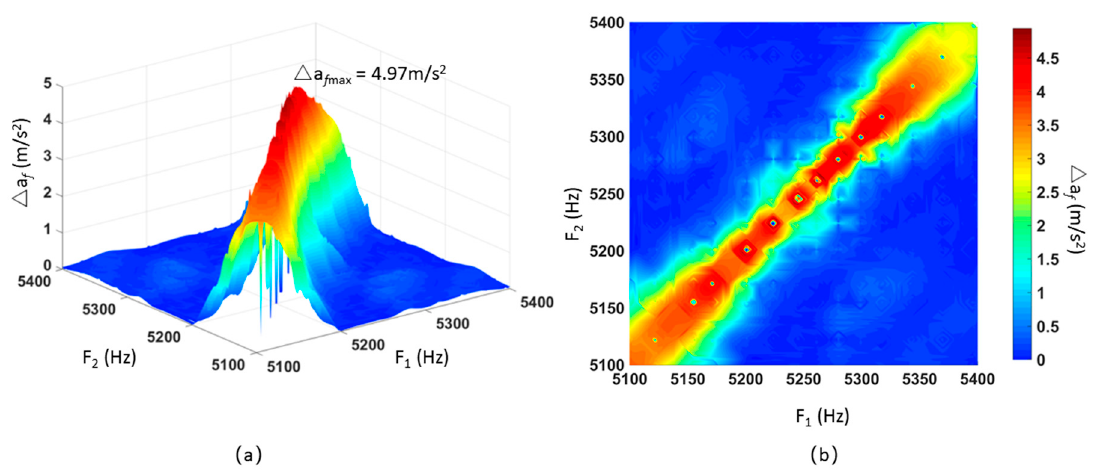
Figure 12. The amplitude of fluctuation for the MEMS accelerometer ADXL103 output under dual sweeping frequency acoustic injections. ( a ) Three-dimensional image. ( b ) Top view.